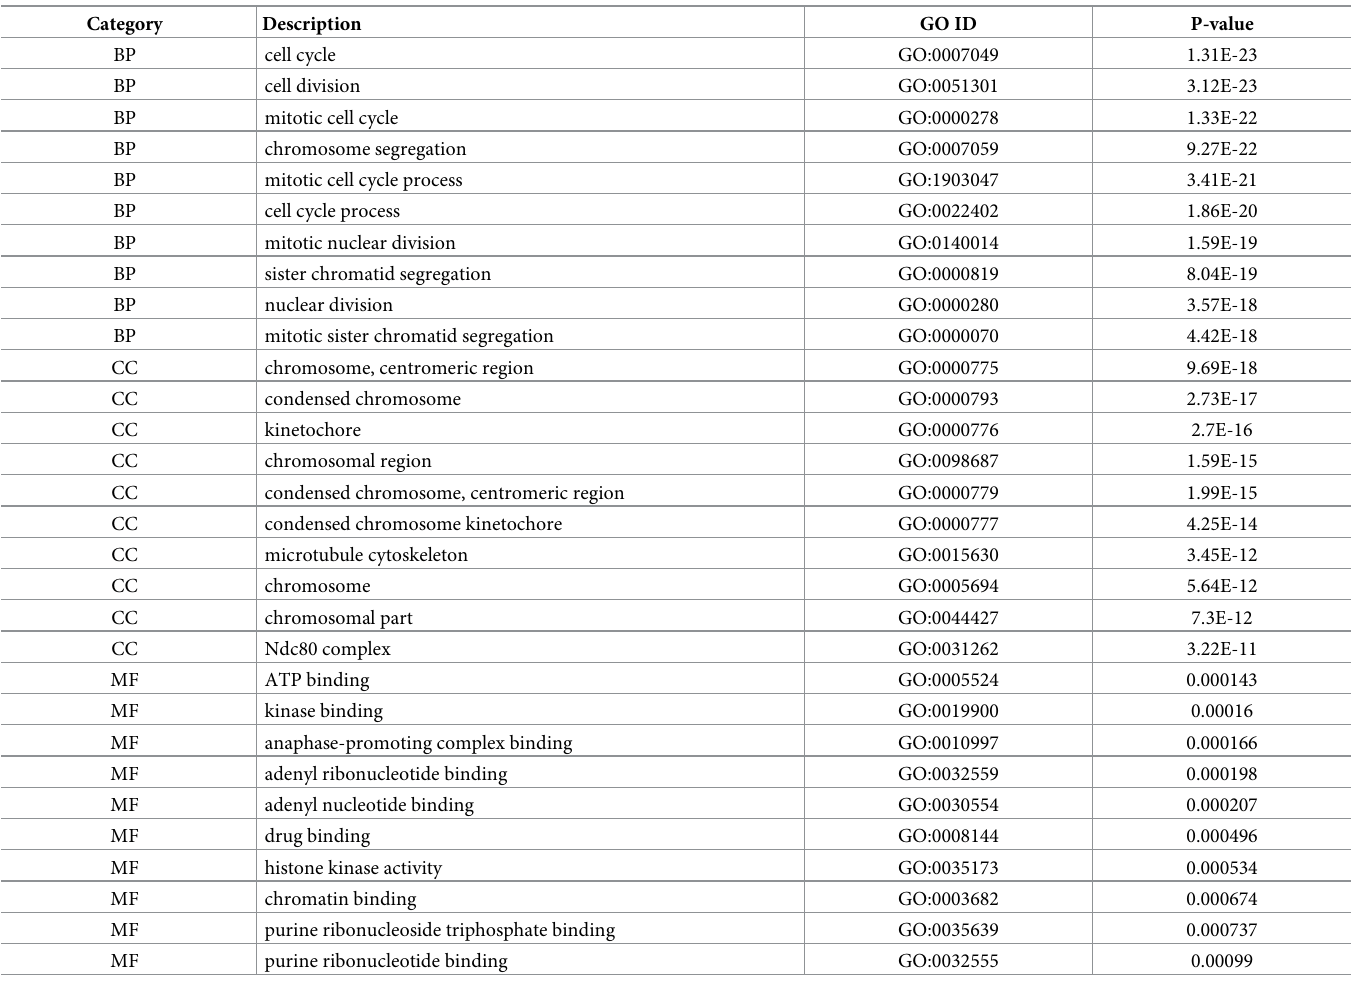
Table 2. GO category, GO description, GO ID, and their corresponding